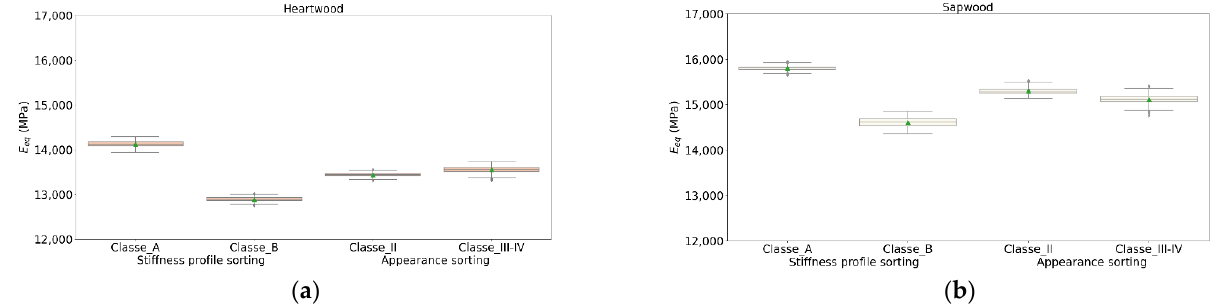
Figure 11. E eq criteria according classes (12% MC): ( a ) heartwood, ( b )